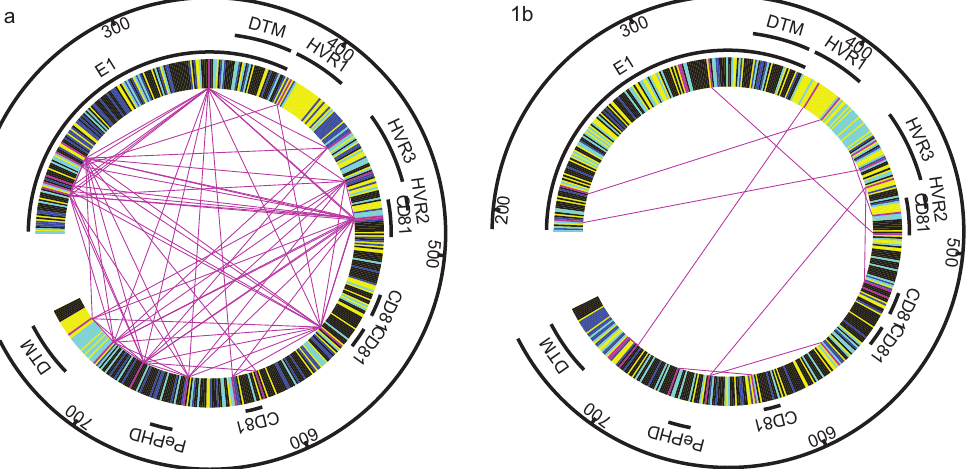
Figure 2. Conserved and covarying regions for 1a and 1b genotypes. Regions are coloured as conserved across both genotypes (black), conserved within each genotype (dark blue), conserved except for a maximum of 2 individuals in that genotype (light blue), and the positions within 50% of maximum covariance in each genotype (magenta) with the covarying pairs shown connected through magenta lines. Regions indicated: E1, transmembrane domains (DTM), hypervariable regions (HVR1, HVR2, HVR3), CD81 binding sites (CD81), and